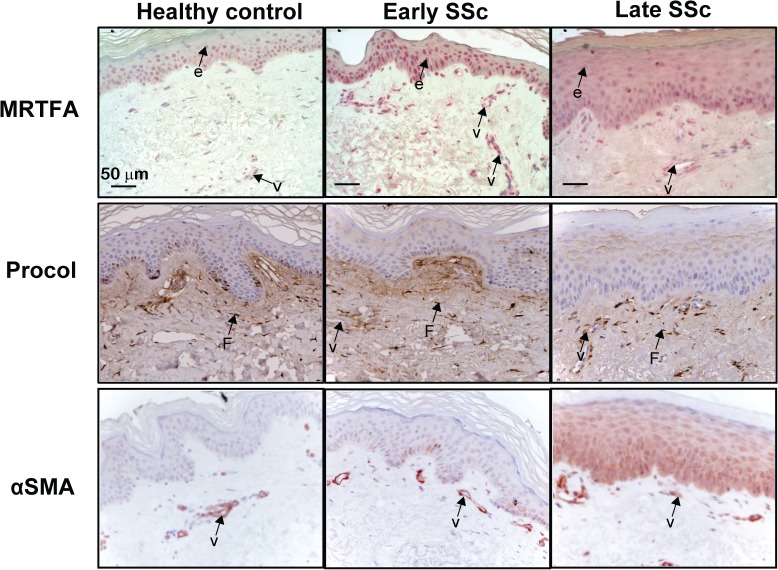
Increased expression of MRTF-A in the SSc epidermis and at the epidermal dermal junction in established SSc correlates with increased intracellular procollagen, and SMA.The expression of MRTF-A, procollagen type I, and SMA was detected by immunohistochemical staining in the epidermis and papillary dermis of early and established SSc patients and controls healthy control patients. Arrows point to staining in vascular cells (V), epidermis (e), and fibroblast (F).